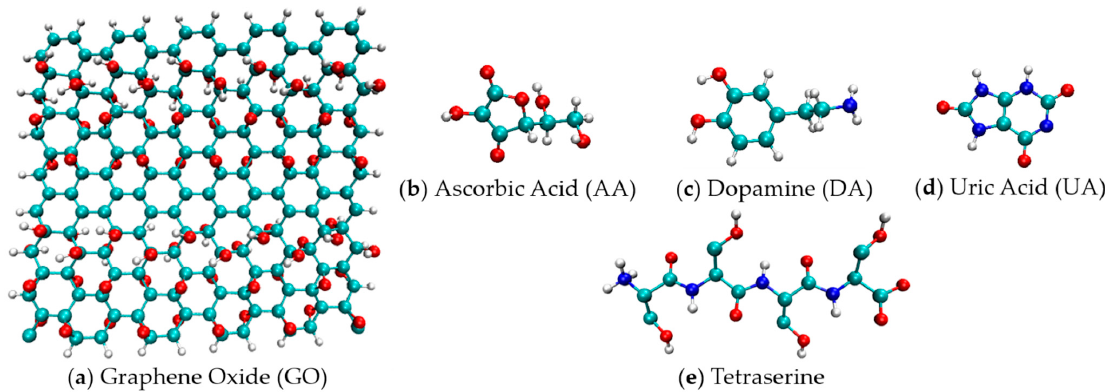
Figure 1. Atomistic structures of the molecular models used in this study: ( a ) graphene oxide; ( b ) ascorbic acid; ( c ) dopamine; ( d ) uric acid; and ( e ) tetraserine .